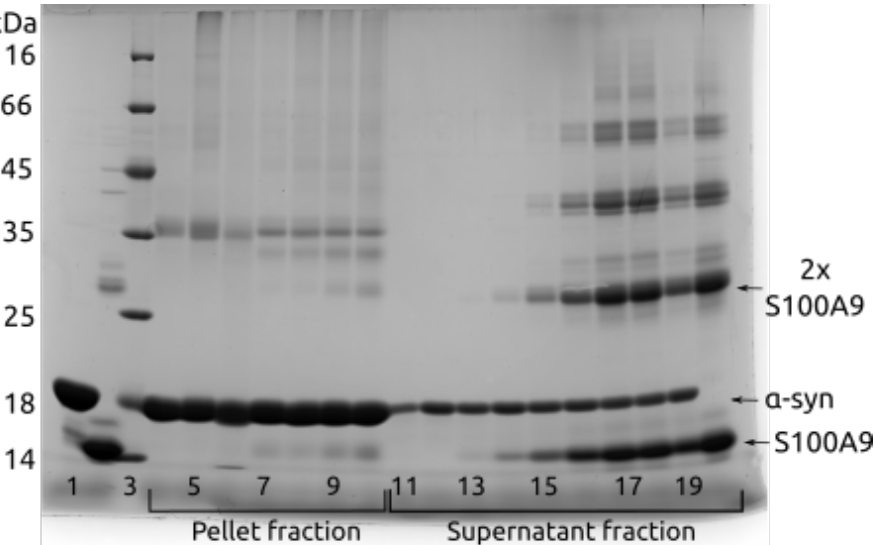
Figure A2. SDS-PAGE gel of α -syn, α -syn–S100A9, S100A9 products after aggregation (samples after aggregation kinetic experiment, FTIR samples). Columns in the gel: (1) 70µM α -syn before aggregation, (2) 70µM S100A9 before aggregation, (3) protein ladder (the molecular weights marked on the right), (4) 70µM α -syn fibrils, (5) α -syn with 2.3µM S100A9 fibrils, (6) α -syn with 4.5µM S100A9 fibrils, (7) α -syn with 9.0µM S100A9 fibrils, (8) α -syn with 18µM S100A9 fibrils, (9) α -syn with 35µM S100A9 fibrils, (10) α -syn with 70µM S100A9 fibrils. Columns of the soluble protein after aggregation α -syn with different concentration of S100A9: (11) 0µM, (12) 2.3µM, (13) 4.5µM, (14) 9.0µM, (15) 18µM, (16) 35µM, (17) 70µM, (18) 70µM sample went through 0.22µm PVDF membrane filter, (19) 35µM filtrate. The soluble protein after aggregation of 70µM S100A9